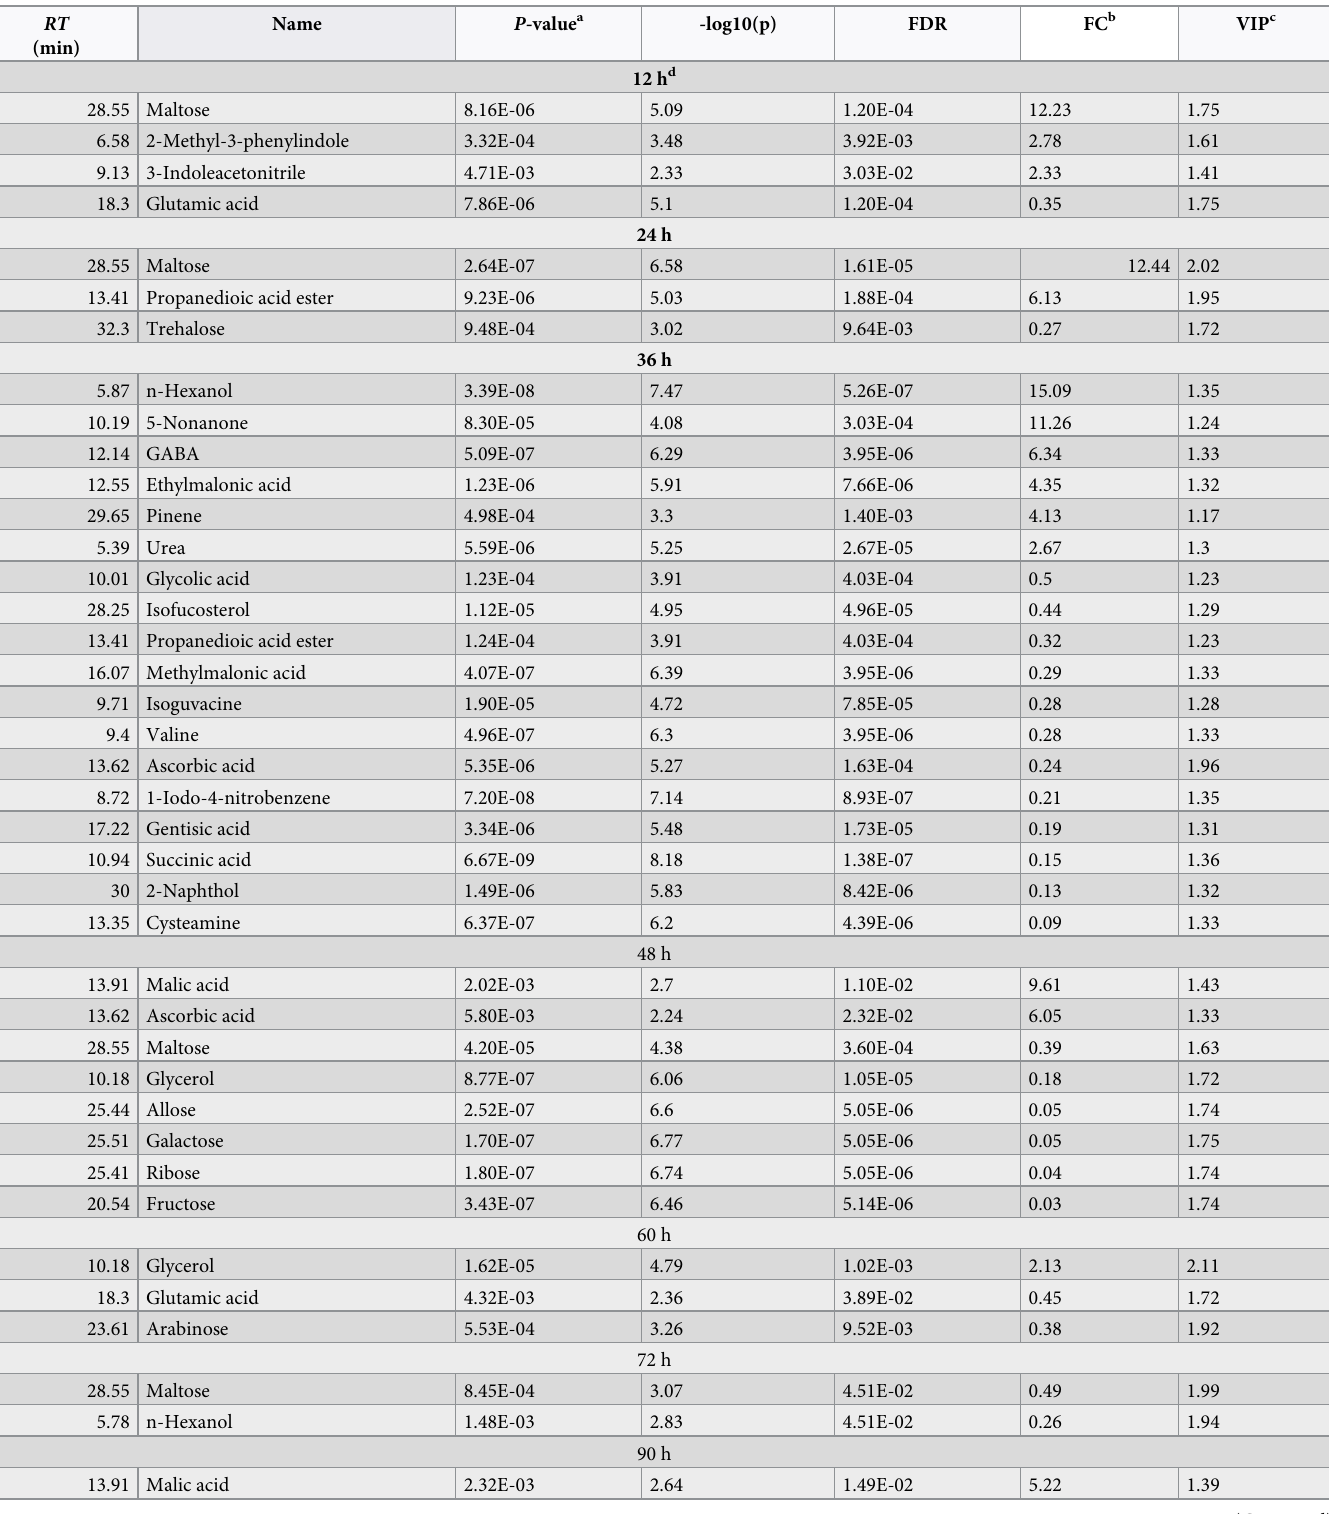
Table 3. Metabolic difference between cut and uncut groups of U . prolifera at each time point. Name P -value a -log10(p) FDR FC b VIP c RT (min) 12 h